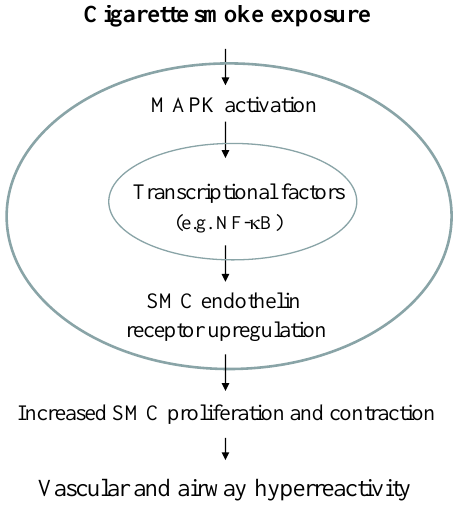
FIGURE 3. Schematic diagram of the MAPK- mediated up-regulation of endothelin receptors. Cigarette smoke exposure may induce the SMC endothelin receptor up-regulation via activation of MAPK-mediated NF-  B signal pathways. The endothelin receptor up-regulation may lead to increased the SMC proliferation and contraction, and subsequently cause vascular and airway hyper- reactivity. The large circle line represents the cell membrane and the small circle line indicates the nuclear